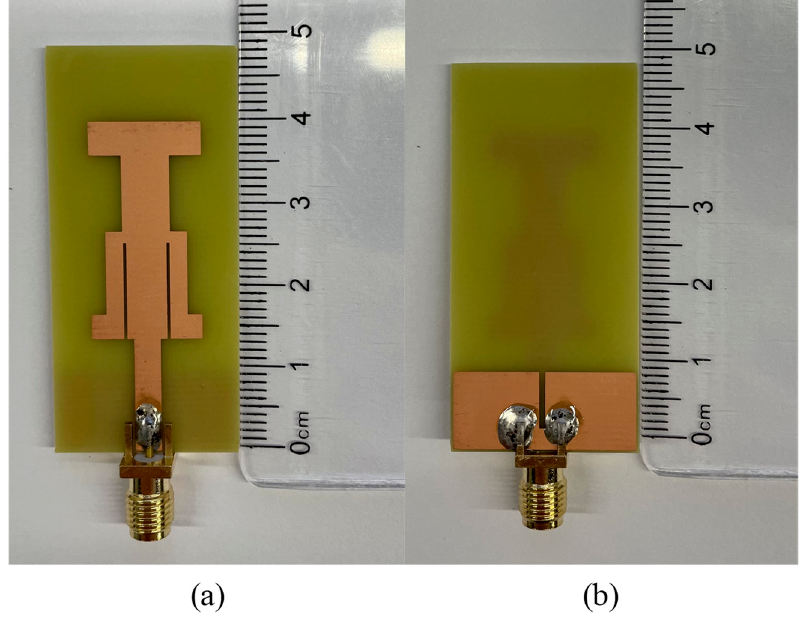
Figure 14. The real antenna: ( a ) front structure of the antenna; ( b ) reverse structure of the antenna.